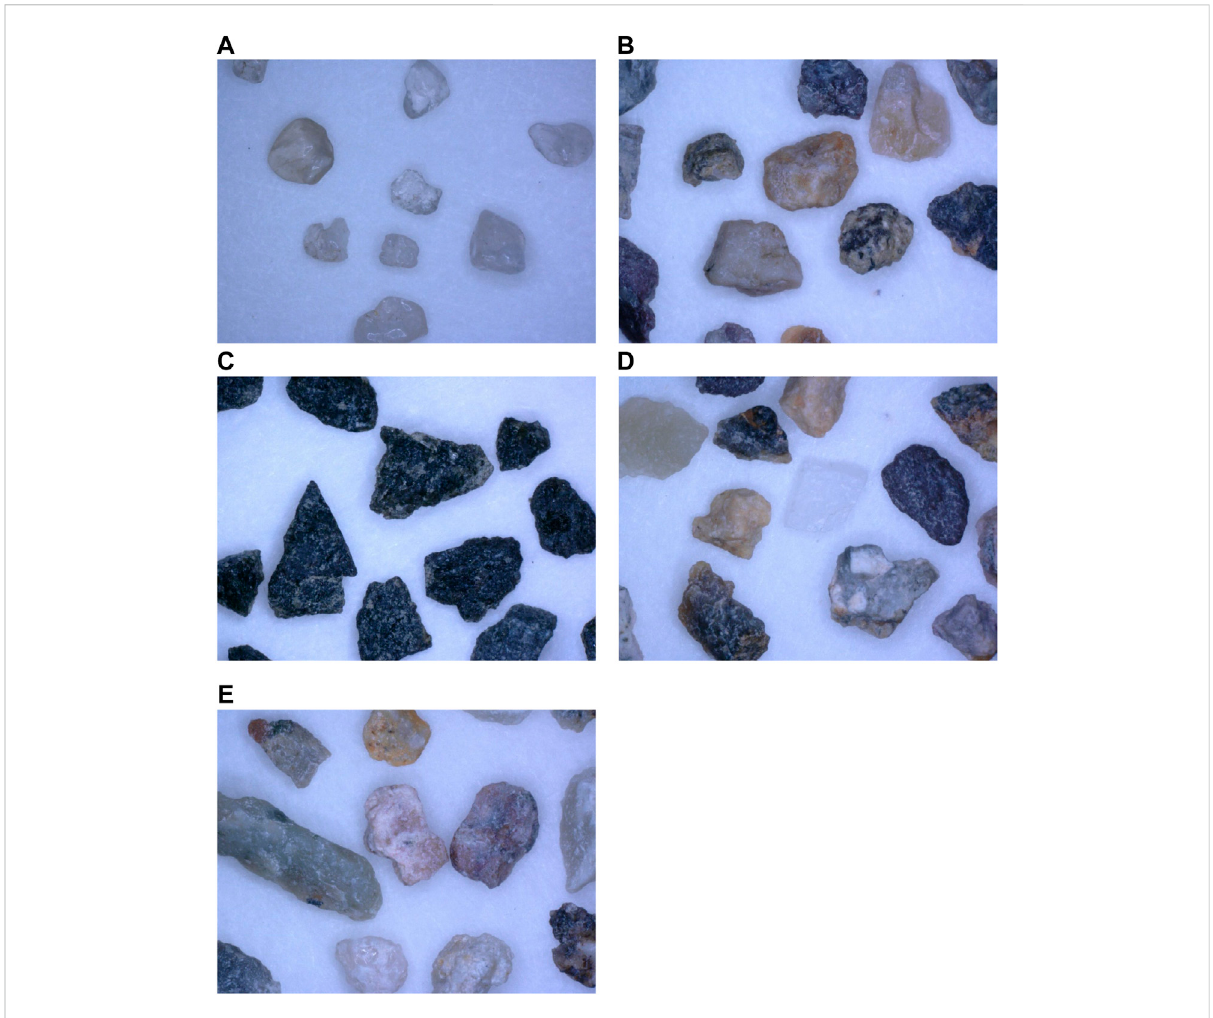
FIGURE 1 Particle images of: (A) QS; (B) RASR; (C) RAB; (D) RAS; (E)